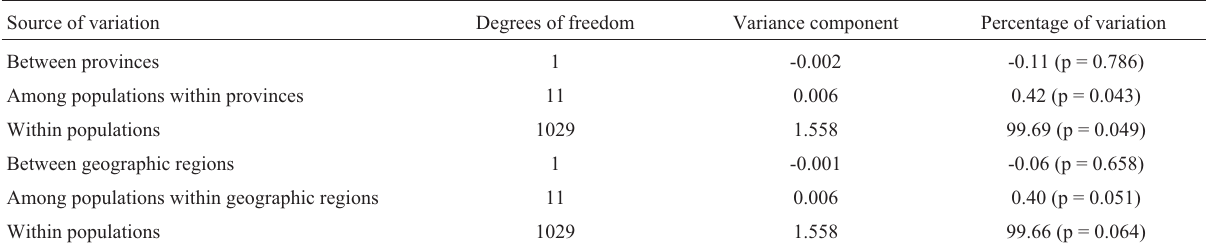
Table4 -Analysisofthemolecularvariancebetweenprovinces(Córdoba vs. SanLuis)andbetweengeographicregions(Sierras vs. Plains)incentralAr- gentina based on the frequencies of 10 AIMs. La Tordilla, Río Cuarto, and La Para are plain populations, while the other sampling sites are located in the sierras